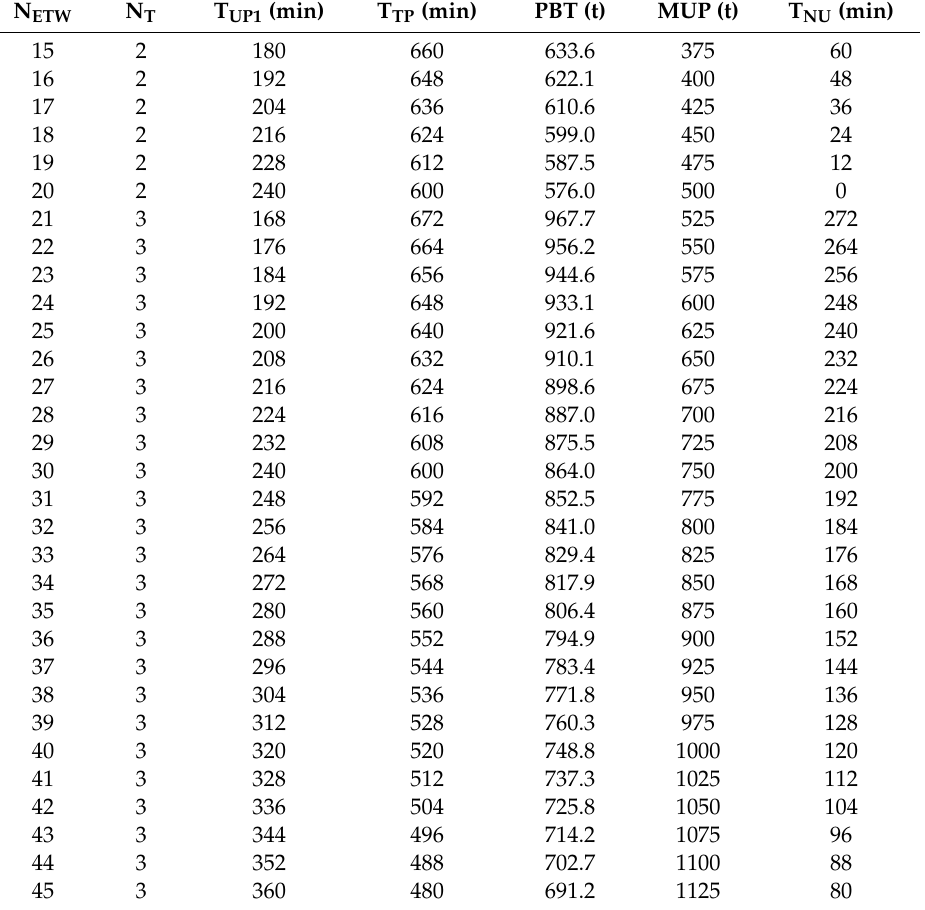
Table 8. Results of the third iteration with E = 0.84 and Q = 576 t with the fleet working two